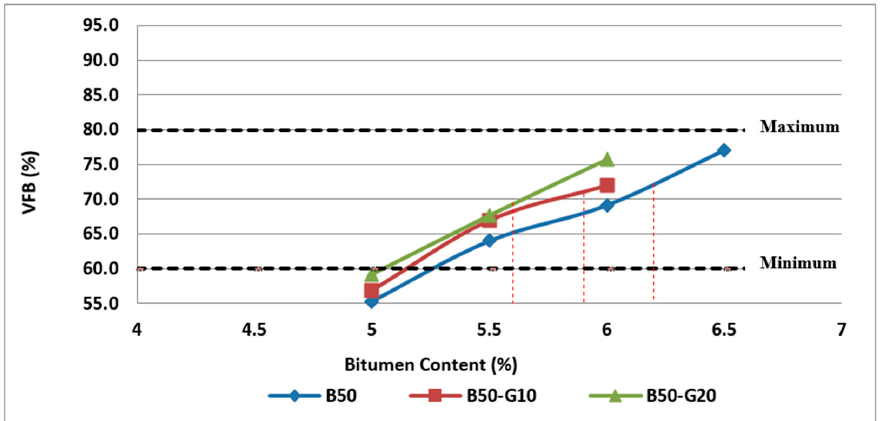
Figure 19. Effect of bitumen content and glass content on VFB of Mix III containing 50% RCA without glass and Mix VI and Mix VII containing 50% RCA as coarse aggregate and glass as fine aggregate.